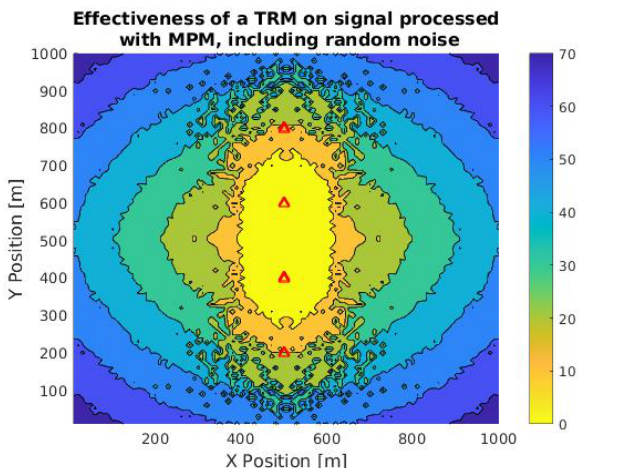
Figure 10. Contour plot of TR calculation accuracy in a TRM in an area of 1 km 2 to a bulk carrier signal previously treated with MPM ( M = 860), and adding random noise in the propagation of the waves. Red triangles are the positions of the sensor and the color scale is a function of the difference between the expected and calculated